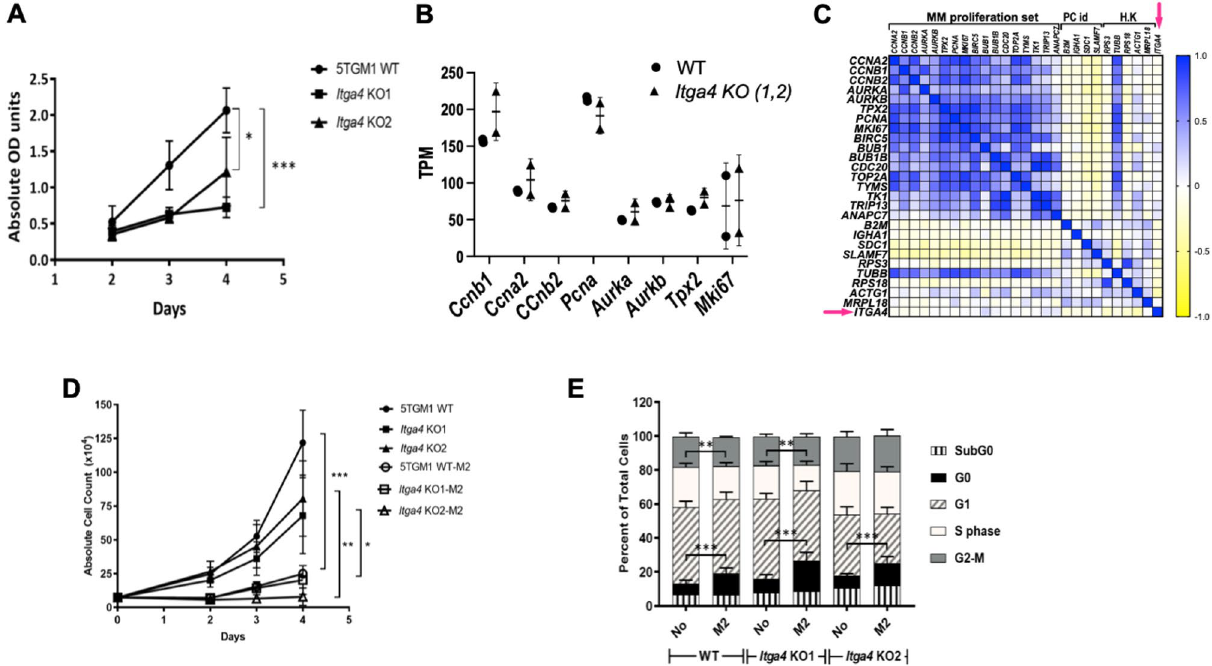
Figure 2. In vitro characterization and functional assessment of Itga4 KO 5TGM1-GFP cells compared to WT 5TGM1-GFP cells. ( A ) The WST-1 proliferation assay comparing the WT with the KO cells. ( B ) gene expression by RNAseq of proliferation-associated genes in 5TGM1 WT and Itga4 KO clones KO1 and KO2. ( C ) Correlation matrix from RNAseq data from patient myeloma cells comparing ITGA4 ( arrow) to the proliferative MM signature genes, plasma cell identity markers, and common housekeeping genes. ( D ) Fluorescence bead count assay to quantify proliferation of Itga4 KO 5TGM1-GFP cells vs WT 5TGM1-GFP cells in the presence and absence of M2-10B4 (M2) stromal cells. The open and dense labels refer to cells cultured with and without M2-10B4 (M2). (E) Cell cycle assay comparing the Itga4 KO 5TGM1-GFP cells vs. WT 5TGM1-GFP cells in the presence and absence of M2-10B4 (M2). Data are shown as mean and SD. All cell biology panels represent the combination of three independent experiments. (* p < 0.05, ** p < 0.01, *** p < 0.001; unpaired t